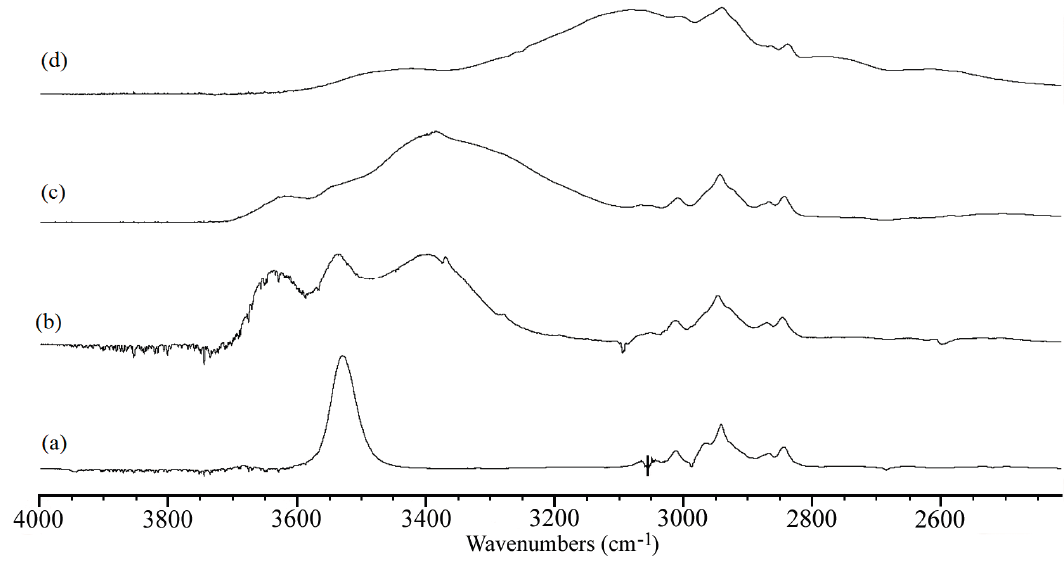
Figure 2. O-H stretching region of the IR-absorption spectra of CYV in solutions of ( a ) dichloromethane; ( b ) ACN; ( c ) acetone; and ( d ) dimethylsulfoxide. The spectrum of carbon tetrachloride was omitted due to the noisiness of the pertaining OH stretching